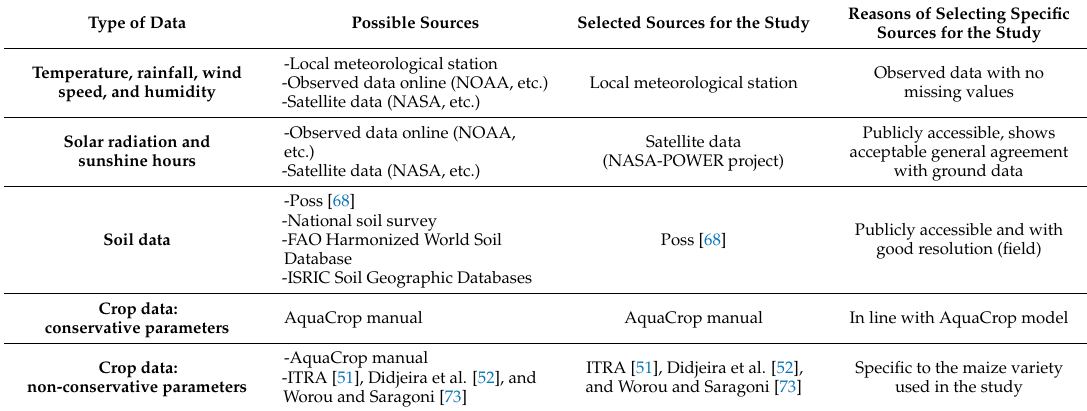
Table 4. Input data